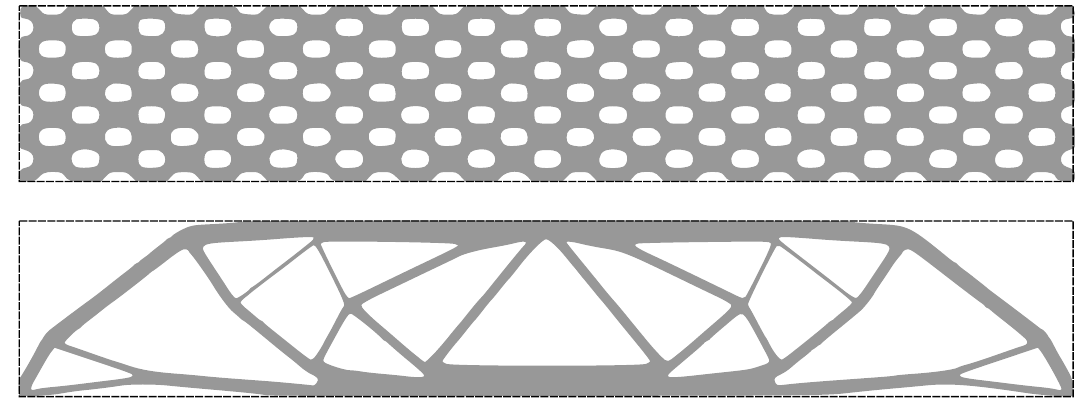
Fig. 3 (Top) initial and (bottom) optimized shapes for Problem (8) in the two-dimensional MBB Beam test-case of Section